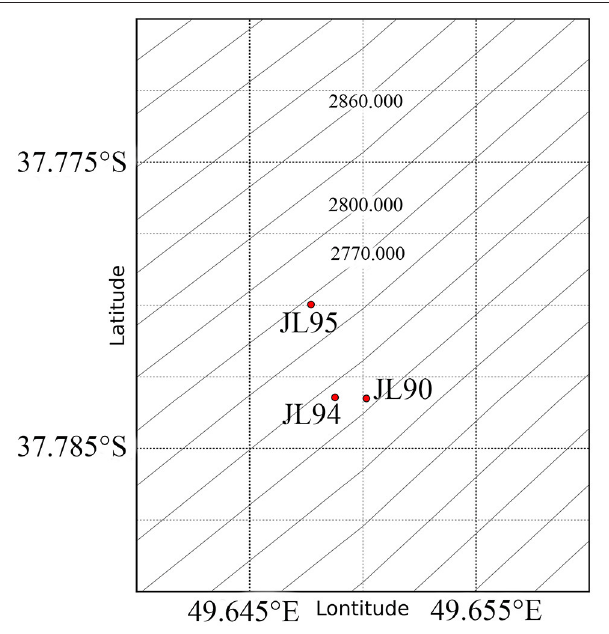
FIGURE 1 | Schematic location of the sampling sites and Longqi vent Field (red Pentagram) at SWIR. The map was created using